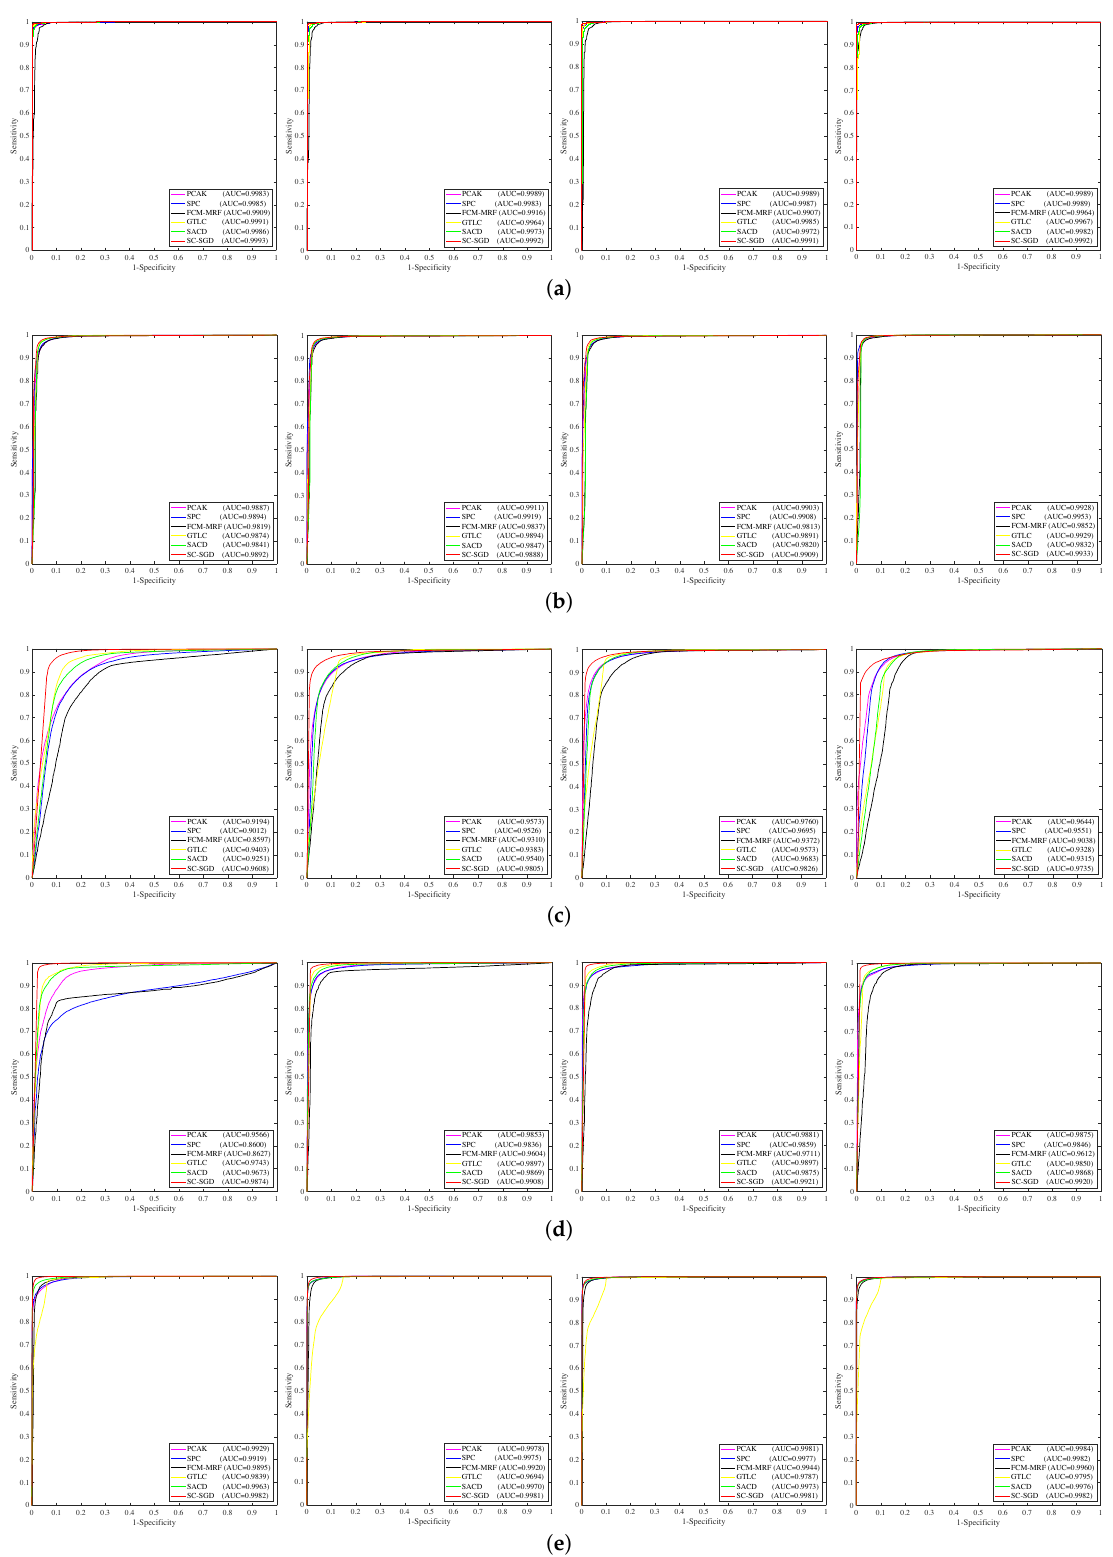
Figure 12. The ROC curves and AUC values of change detections on both raw and despeckled images by MMSE, SAR-BM3D, and PPB, respectively. ( a ) Bern dataset. ( b ) San Francisco dataset. ( c ) Yellow River A dataset. ( d ) Yellow River B dataset. ( e ) Ottawa dataset.